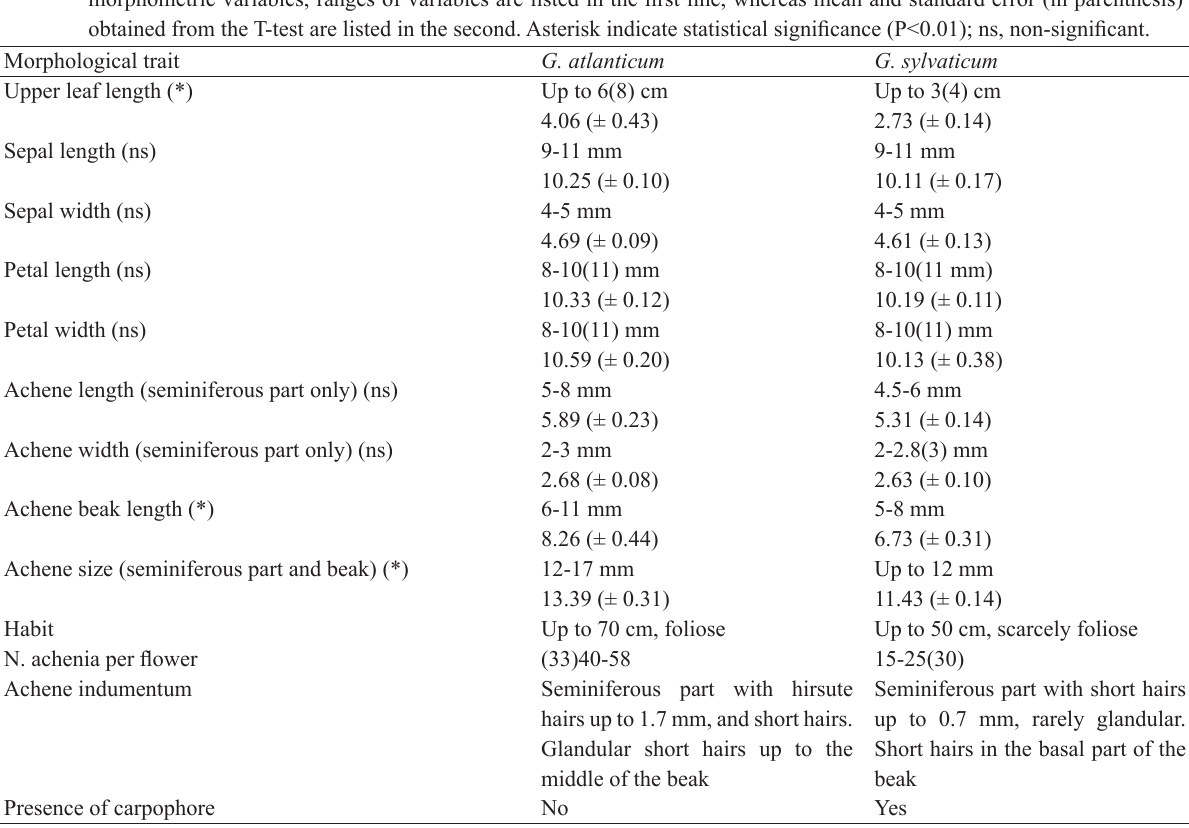
Table 1. Main morphological traits studied for Geum atlanticum Desf. and Geum sylvaticum Pourr. Morphometric variables are listed in the upper rows, whereas variables not included in the morphometric analysis are listed in the lower ones. For the morphometric variables, ranges of variables are listed in the first line, whereas mean and standard error (in parenthesis) obtained from the T-test are listed in the second. Asterisk indicate statistical significance (P<0.01); ns, non-significant. Morphological